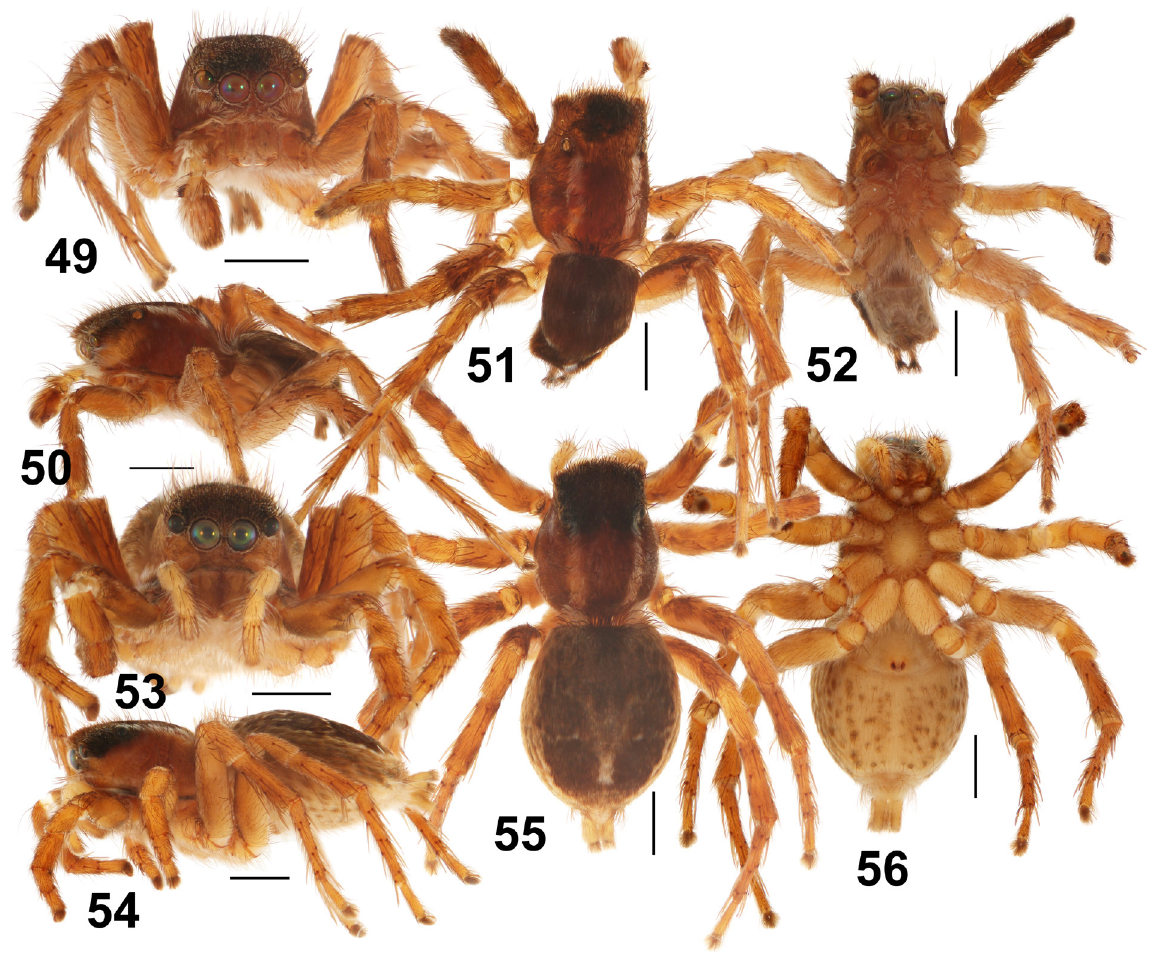
Figs 49–56. Stenaelurillus albopunctatus Caporiacco, 1949 from Kenya (Nairobi), general appearance. 49–52 . ♂ (Langata, MMUE G7583.1). 53–56 . ♀ (grounds of National Museum, MMUE G7583.2). Scale bars: 1